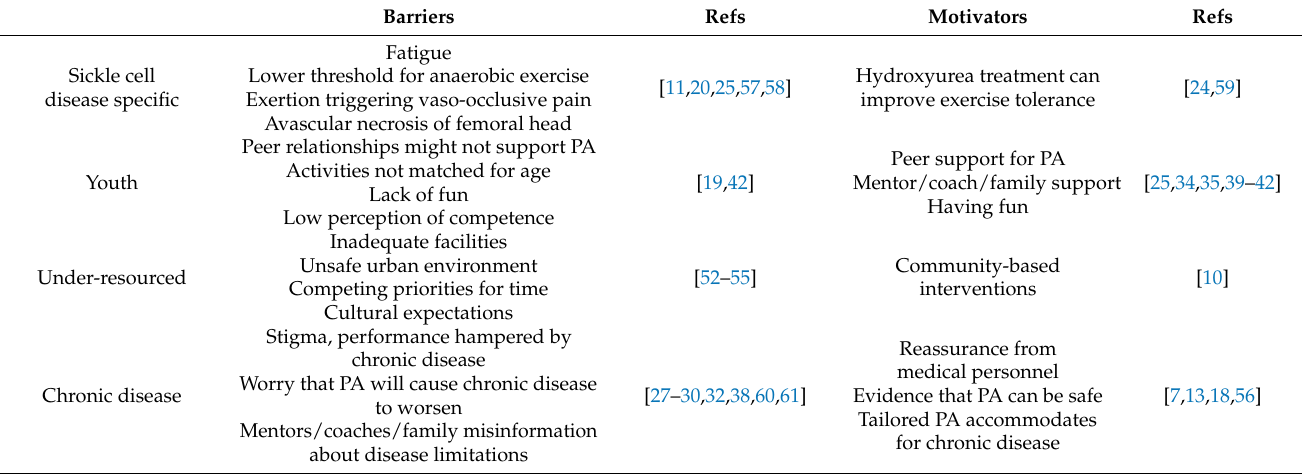
Table 2. Physical activity motivators and barriers for youth with sickle cell